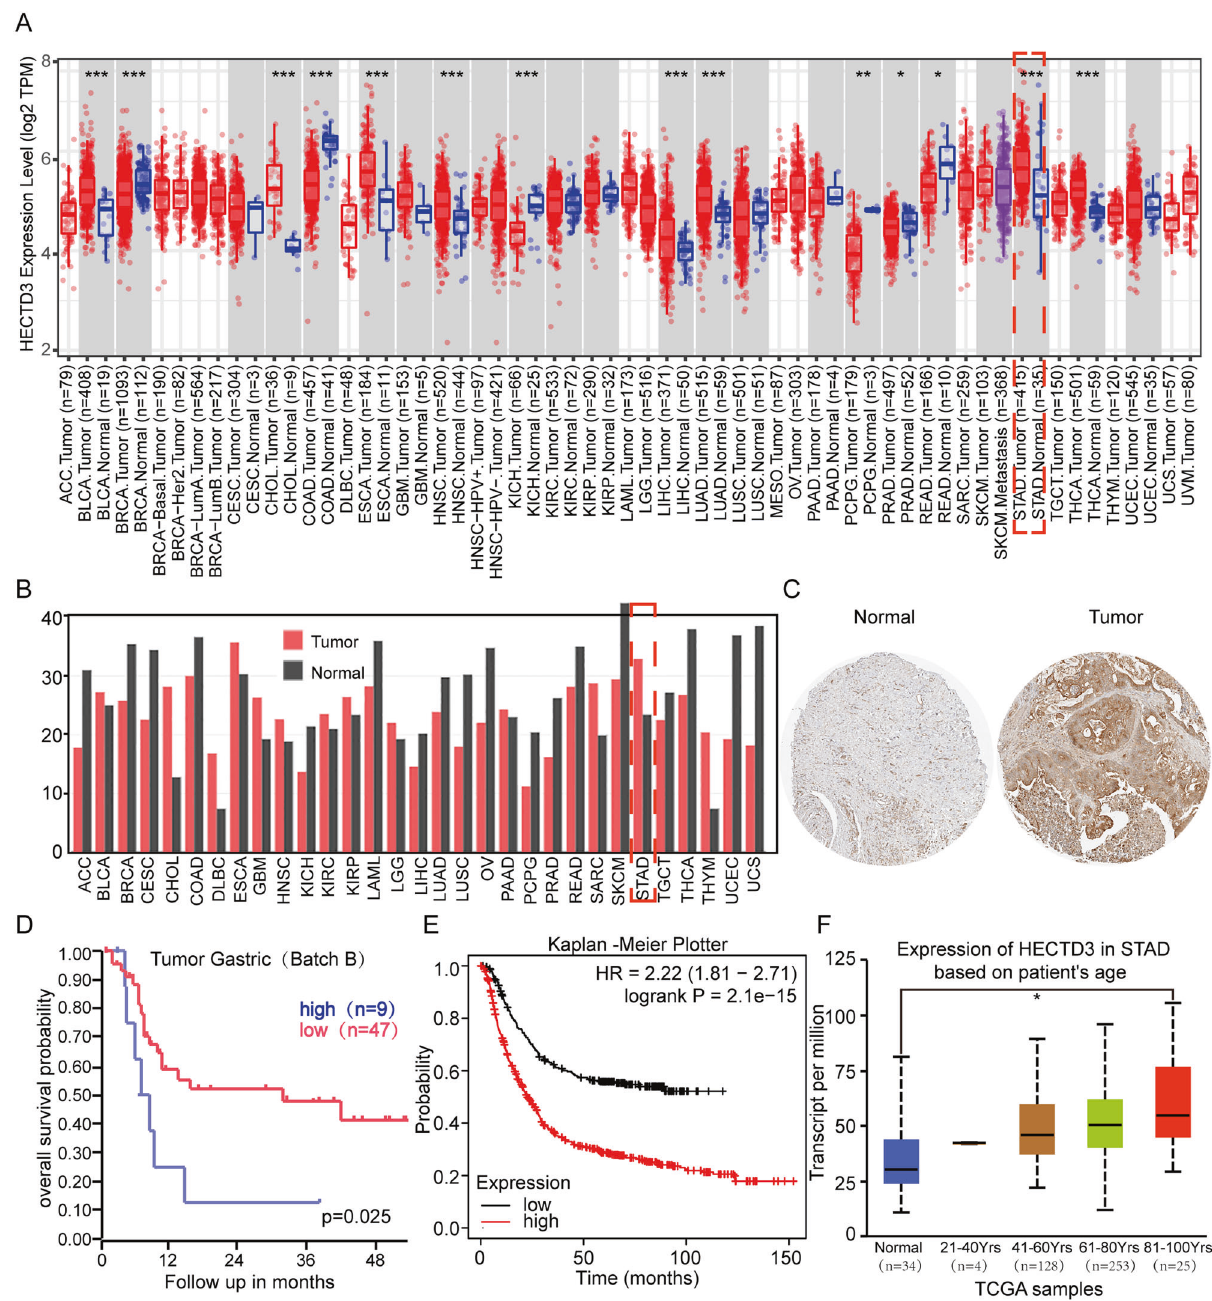
Fig. 1 Abnormal activation of HECTD3 in gastric cancer leads to poor prognosis for patients. A , B Expression of HECTD3 in gastric cancer and many other tumor types was determined using the TIMER2 (http://timer.cistrome.org/) and GEPIA (http://gepia.cancer-pku.cn/index.html) databases. C Protein Atlas database (http://www.proteinatlas.org/) was adopted to check expression of HECTD3 in human nontumor gastric mucosa and gastric cancer. D , E The R2 database and Kaplan – Meier plotter were applied to detect prognostic signi fi cance of HECTD3. F The expression of HECTD3 was analyzed through the UALCAN